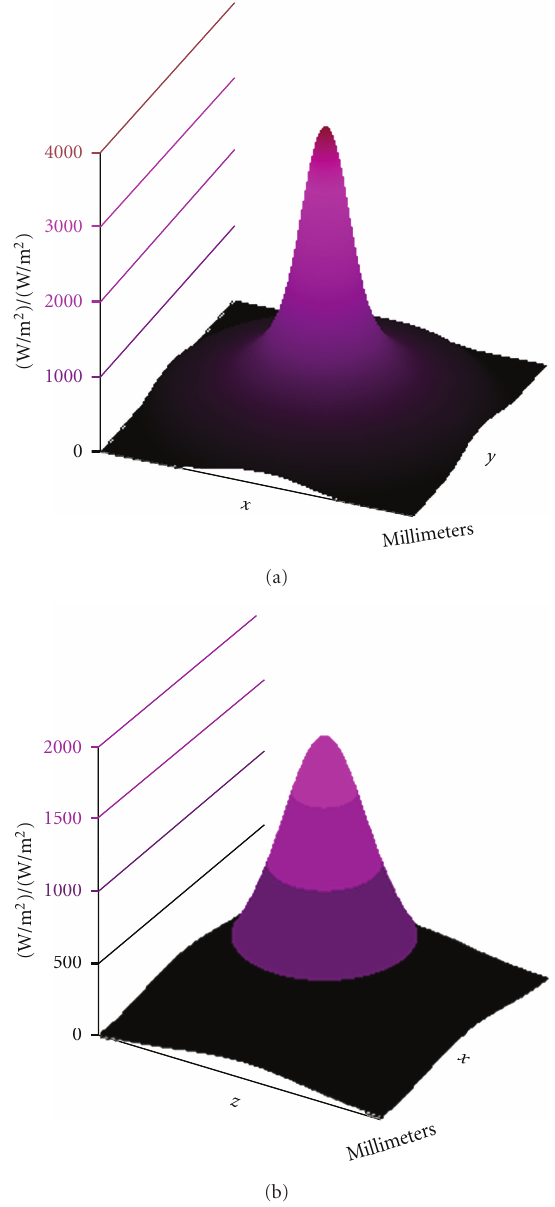
Figure 10: 3D irradiance distribution on the cell when the sun ray is at normal incidence. (a) Traditional Fresnel lens. (b) Novel compound Fresnel